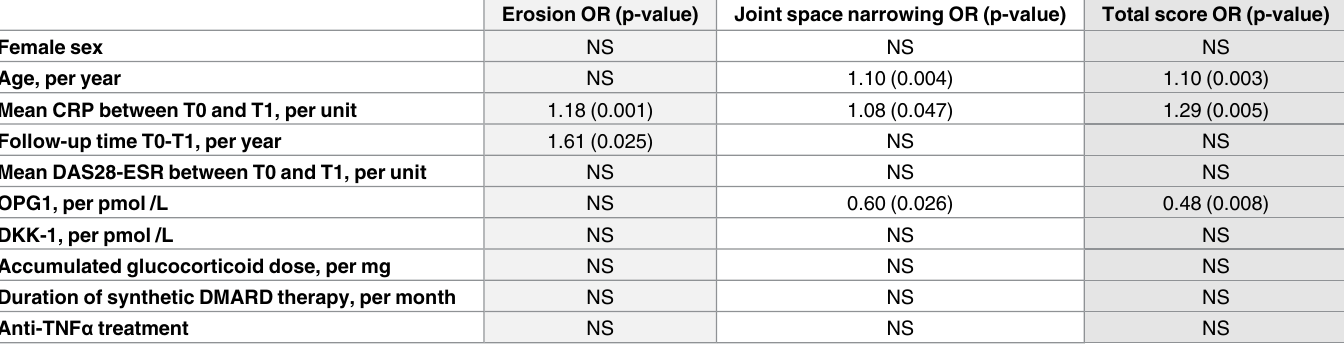
Table 3. Factors associated with radiographic progression by the Sharp-van der Heijde score (total and by subscales): results of the multivariate regression models by backward stepwise selection. Erosion OR (p-value) Joint space narrowing OR (p-value) Total score OR (p-value)